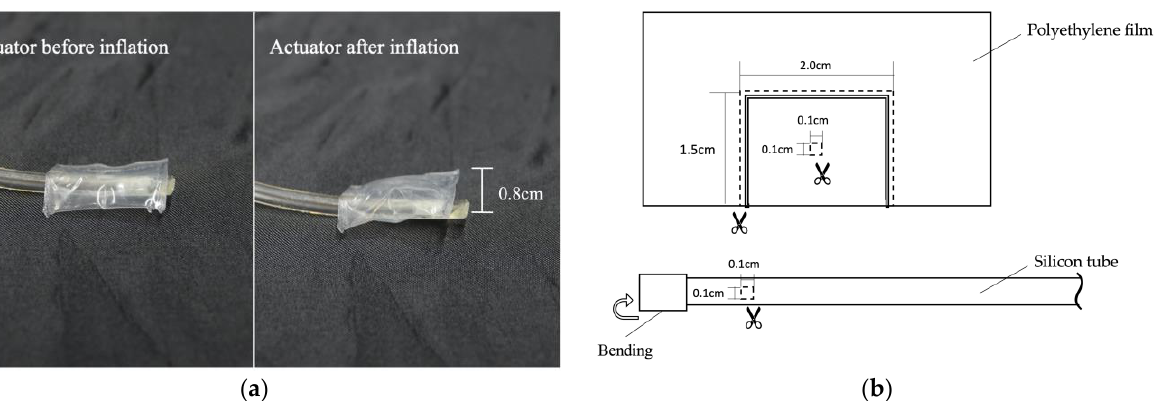
Figure 3. Fabrication procedure for pneumatic actuators. A rectangular outline was drawn on a poly-ethylene film ( a ), then a cookie sheet was placed over the film ( b ). The rectangular outline was traced over the cookie sheet with a soldering iron ( c ), and then the welded area was cut out ( d ). 3.2. Prototype Figure 4a shows the prototype of the navigation device consisting of pneumatic ac- tuators. Four actuators mounted at equal intervals around the neck can apply pressure in eight directions. For example, activation of the two front actuators indicates forward di- rection, and activation of one of the actuators located on the forward diagonal left side indicates a diagonal movement towards the left side. To improve wearing comfort and stability, we covered the actuators with a soft fabric (Figure 4b). The proposed method assumes that each actuator is controlled by an electronic device that automatically delivers air. However, this study aims to create a prototype and only check the feel of the actuator; thus, the actuators were manually operated using a syringe. The choker used is a standard commercial product with a length of 40.0 cm and a thickness of 1.5 cm (Figure 4c).